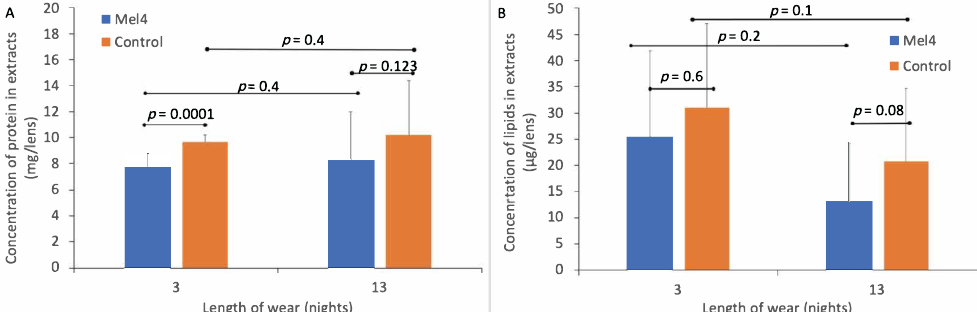
Figure 2. Amount of protein ( A ) and lipid ( B ) deposited on Mel4-coated and control lenses during wear.